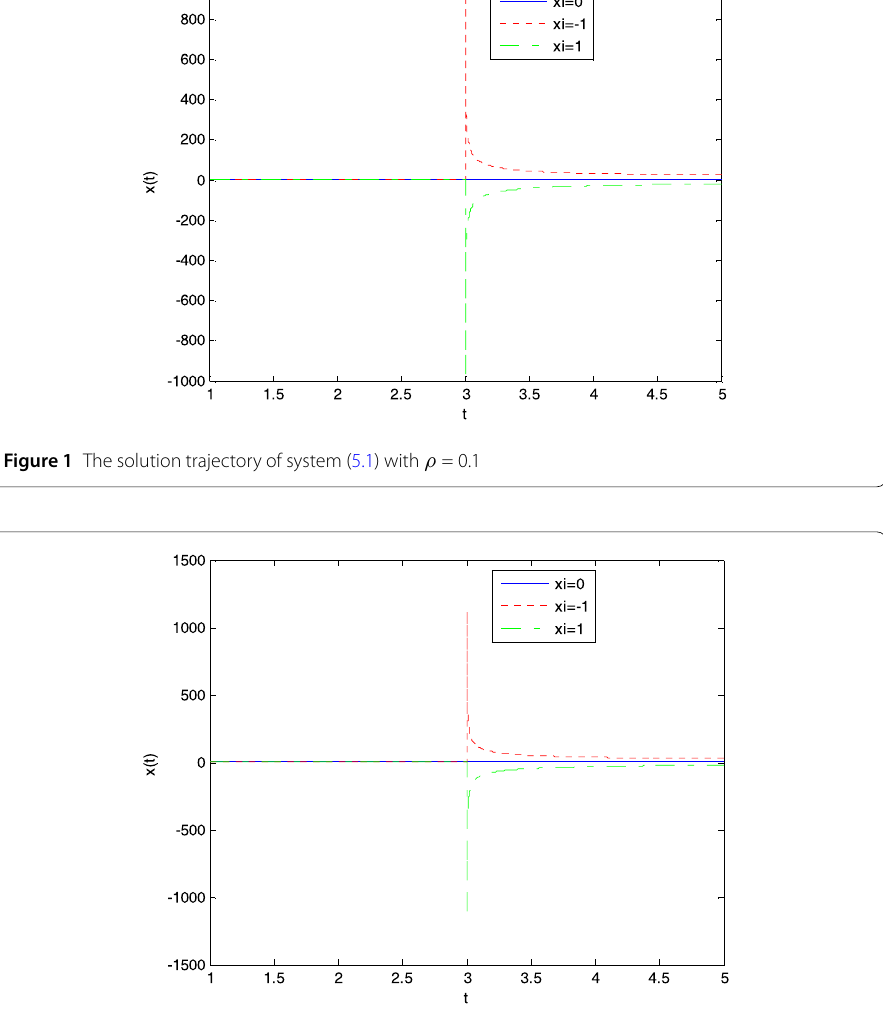
Figure 2 The solution trajectory of system (5.1) with ρ =